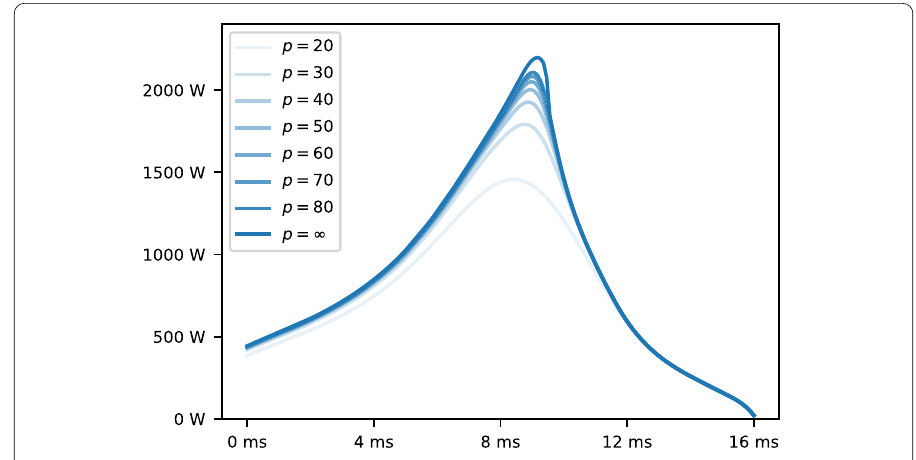
Figure 7 Solutions to a sequence of optimal control problems with variable parameter p . Zero initial guess is taken for the smallest value of p and each subsequent problem utilizes previously computed optimal control as the initial guess